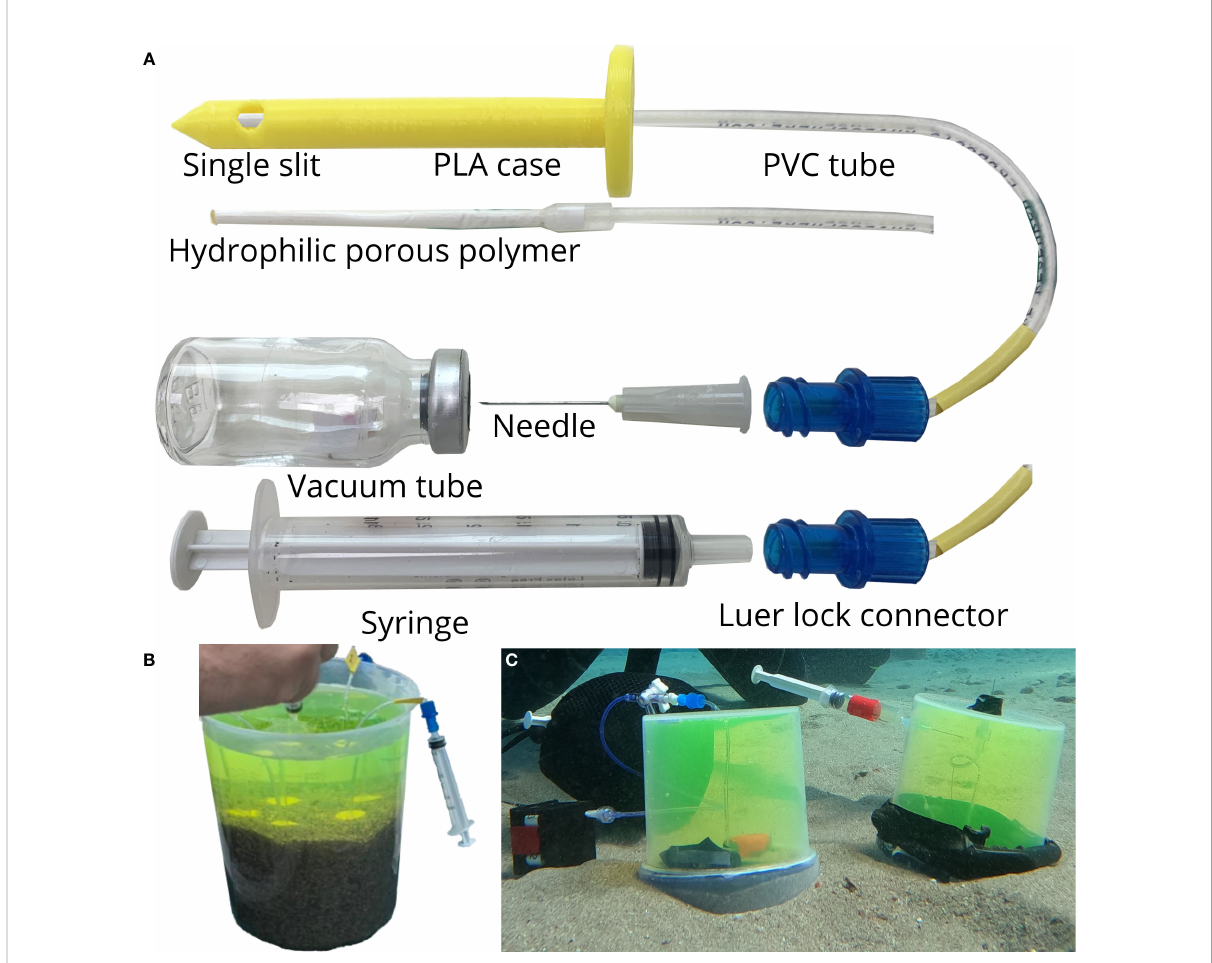
FIGURE 2 Schematic representation and photographs taken by the authors showing the Rhizon sampler setup and its application. (A) PLA/ABS case with a single slit opening which covers the hydrophilic porous polymer end of the Rhizon (length 5 cm, outer diameter 2.5 mm, pore size 0.1 µm, dead volume 0.5 mL) and the devices used for extracting pore water (vacuum vial, syringe). Pore water extraction by (B) inserting Rhizons through sediment and syringes in an experimental setup conducted in lab, and (C) inserting Rhizons through sediment and vacuum tubes in